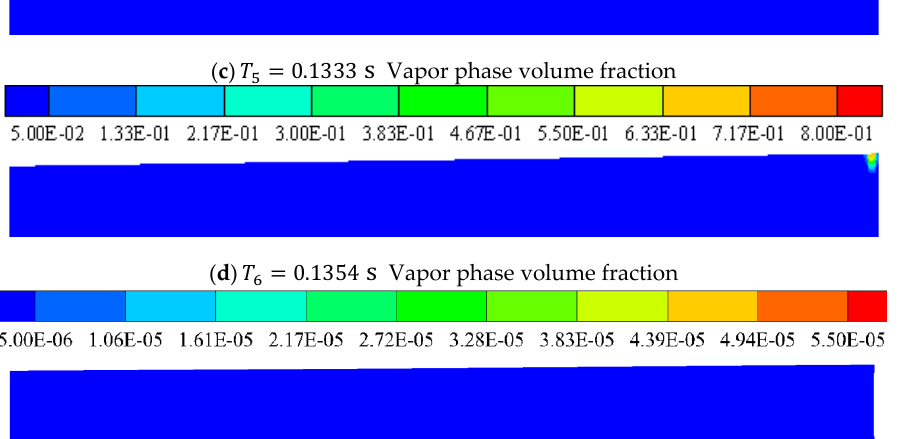
Figure 33. Evolution of vapor volume fraction on the axis plane of the pipeline in the cavity collapse stage.